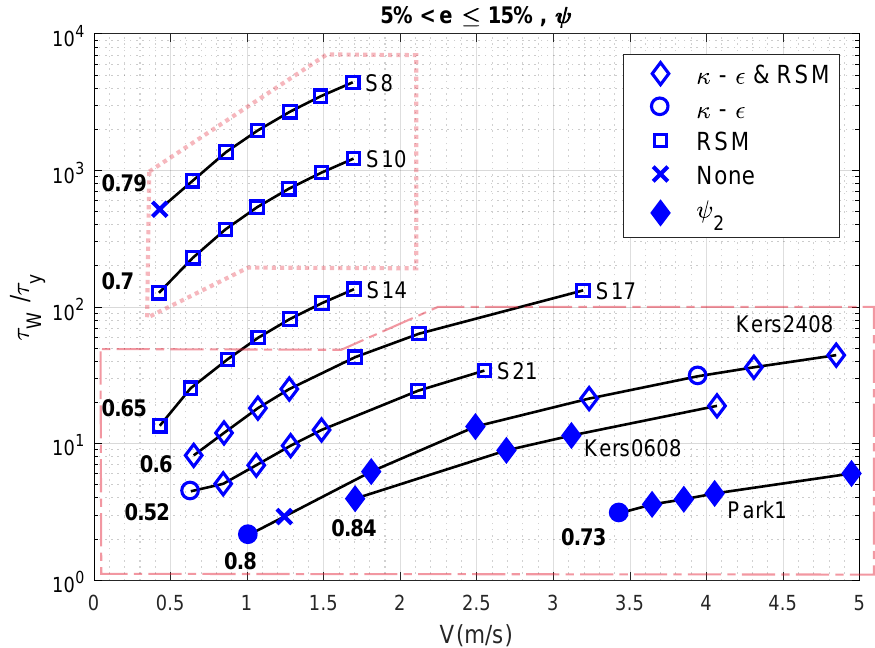
Figure 12. Performance of the standard RANS models combined with ψ 1 to achieve an error 5% < e ≤ 15%. This trend is most apparent when τ W / τ y is less than 20. Such a low ratio is attained when the rheological yield stress is high or when a slurry with a moderate to high yield stress flows with a small flow velocity, as suggested by Figures 9–12. Furthermore, when the ratio τ W / τ y is less than 10, more than one-tenth of the pipe’s radial extent is theoretically occupied by an unyielding region that does not promote turbulent mixing. This therefore requires the use of ψ 2 to obtain a numerically converged and accurate solution, as shown by shaded (filled) symbols in Figures 10 and